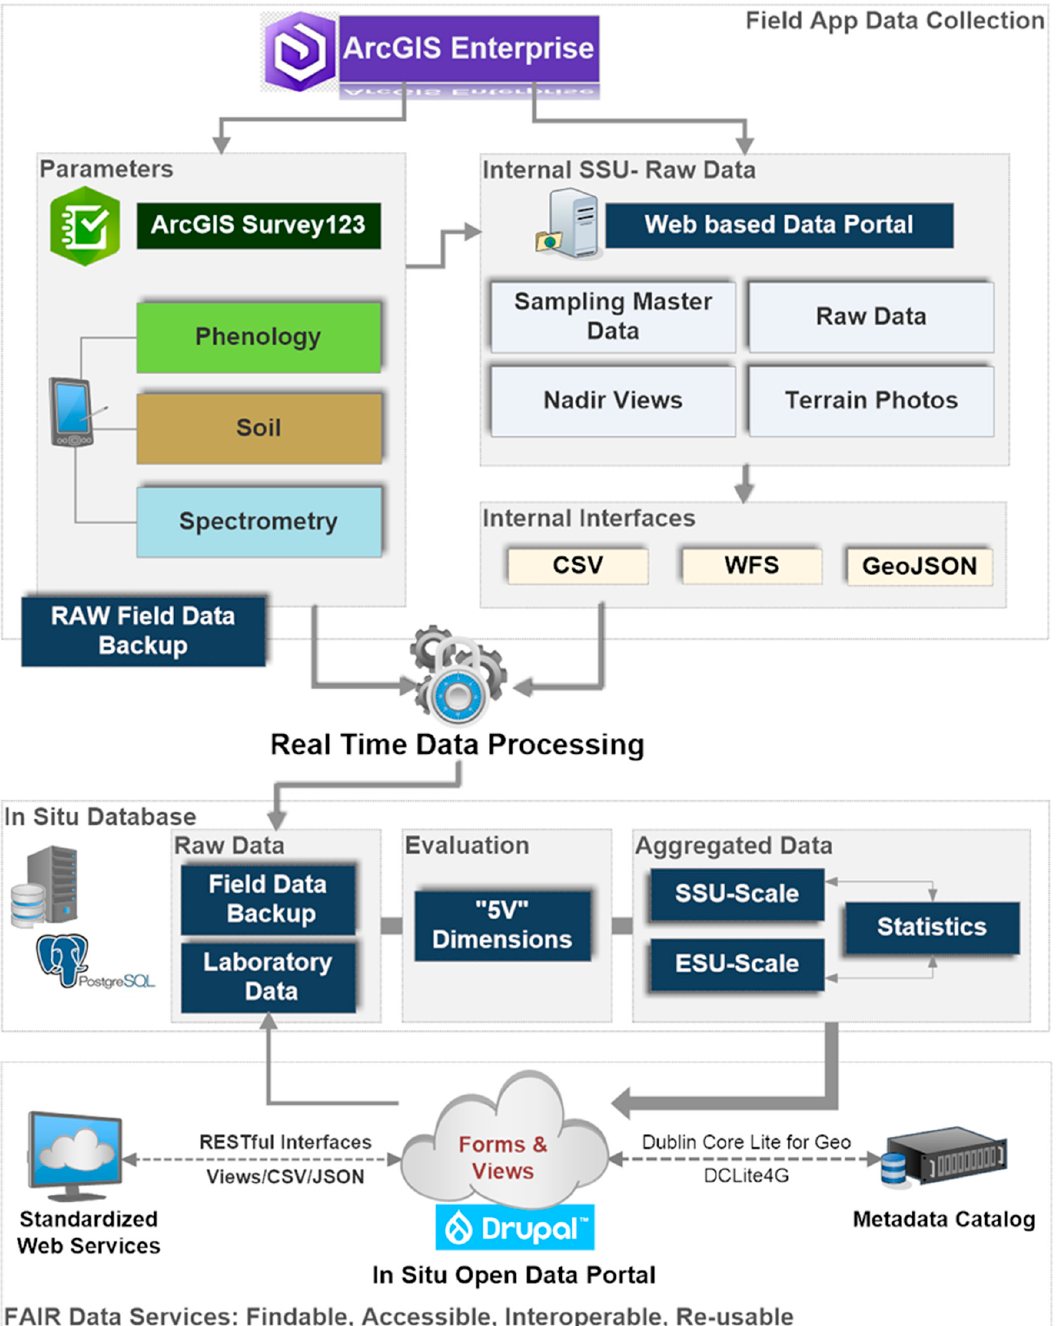
Figure 2. Schematic data flow from collection in the field to standardized web-based Fair Data Ser- vices.